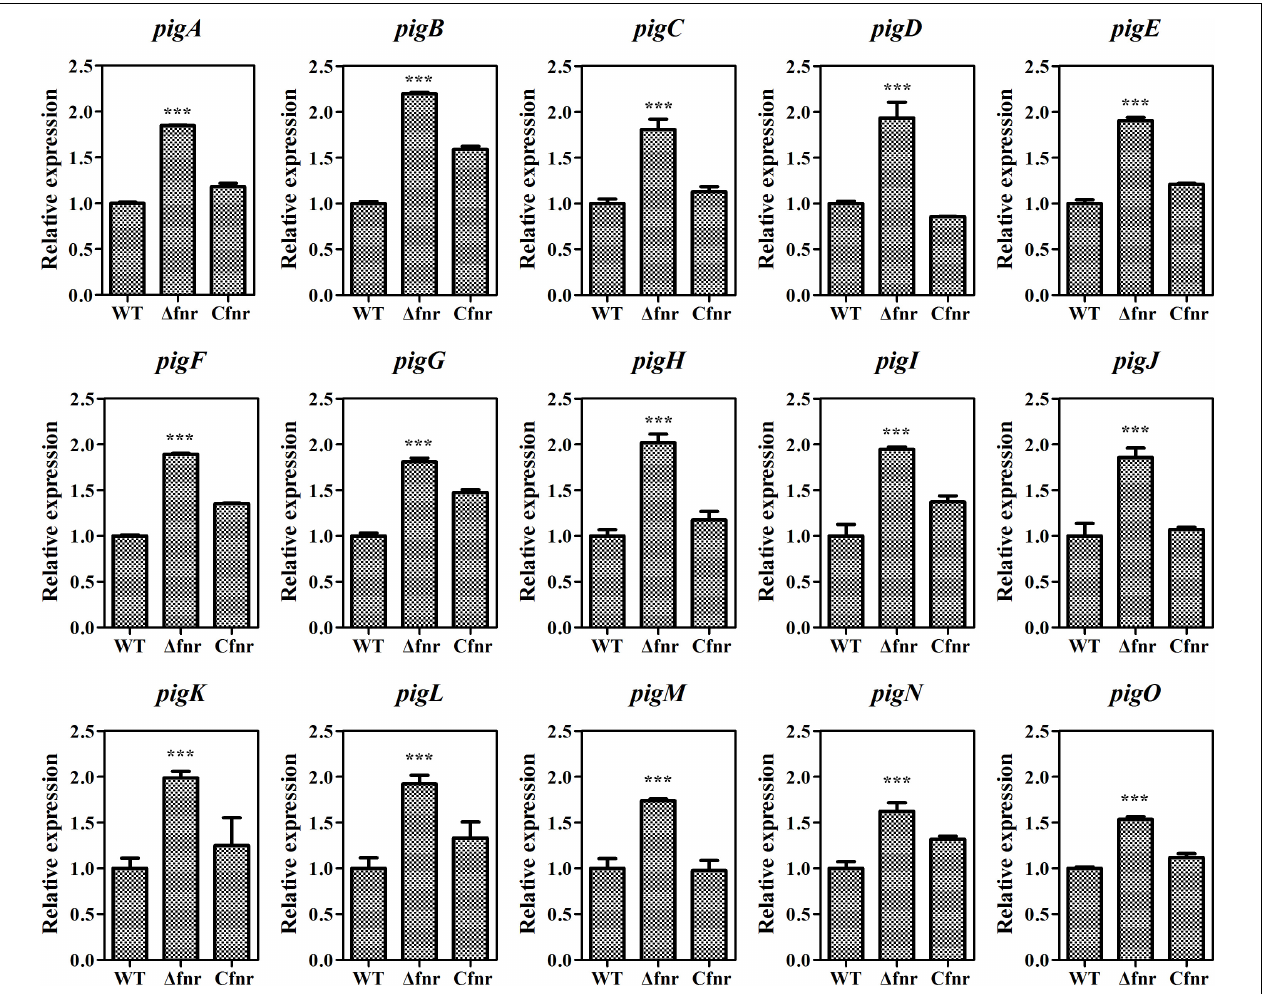
FIGURE 2 | Fnr negatively regulates pig gene transcription. The transcription level of the tested genes in WT was assigned as 1, and the transcription levels of tested genes in (cid:49) fnr and C fnr are displayed as fold changes. The experiments were performed in triplicate, and the data are shown as the mean ± SD. Student’s t -test was used to analyze the statistical significance (*** p <